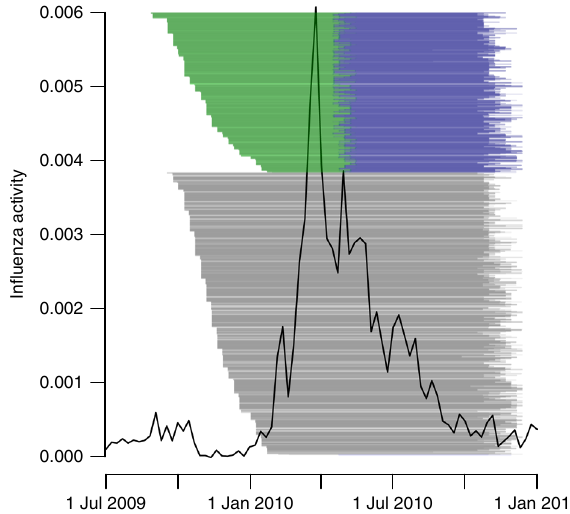
Fig. 2 Timeline of the study and in fl uenza virus activity for in fl uenza B epidemic in Hong Kong. The black line denotes the local in fl uenza activity in Hong Kong, as approximated by in fl uenza-like illness consultation rates multiplied by the proportion of laboratory specimens testing positive for in fl uenza B virus (ILI + proxy). The green, blue, and black lines indicate the pairs of sera drawn in rounds 1 + 2, rounds 2 + 3, and rounds 1 + 3,